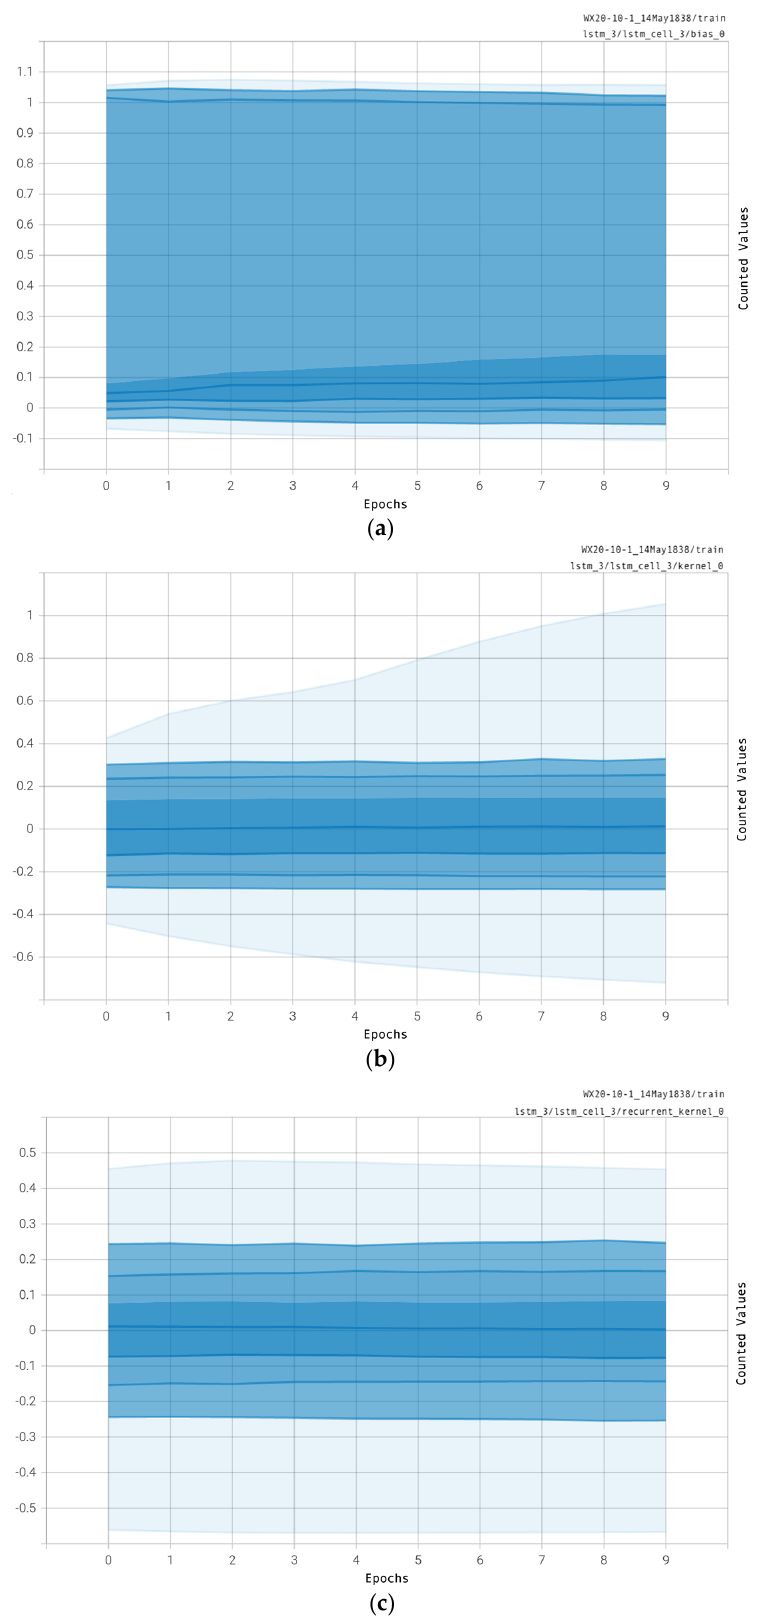
Figure 9. Weather events: distribution plots. ( a ) Bias LSTM cell three; ( b ) Kernel LSTM cell three; ( c ) Recurrent kernel LSTM cell three.